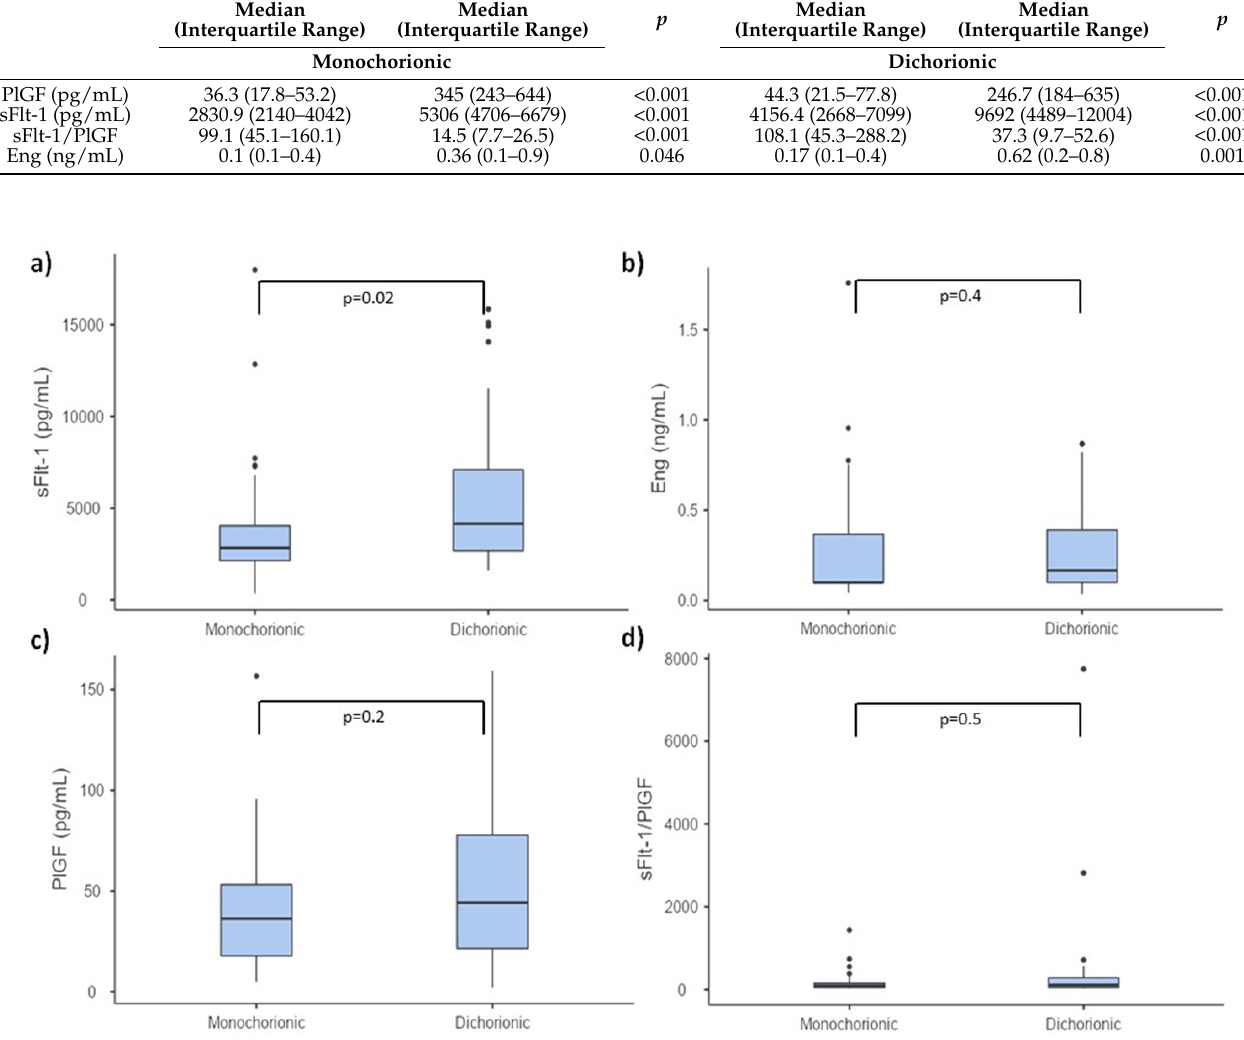
Figure 2. Box-and-whisker plots showing serum values of PlGF, sFlt-1, sFlt-1/PlGF ratio and sEng measured in the third trimester of twin pregnancy. ( a ) sFlt-1; ( b ) sEng; ( c ) PlGF; ( d ) sFlt-1/PlGF serum concentration.